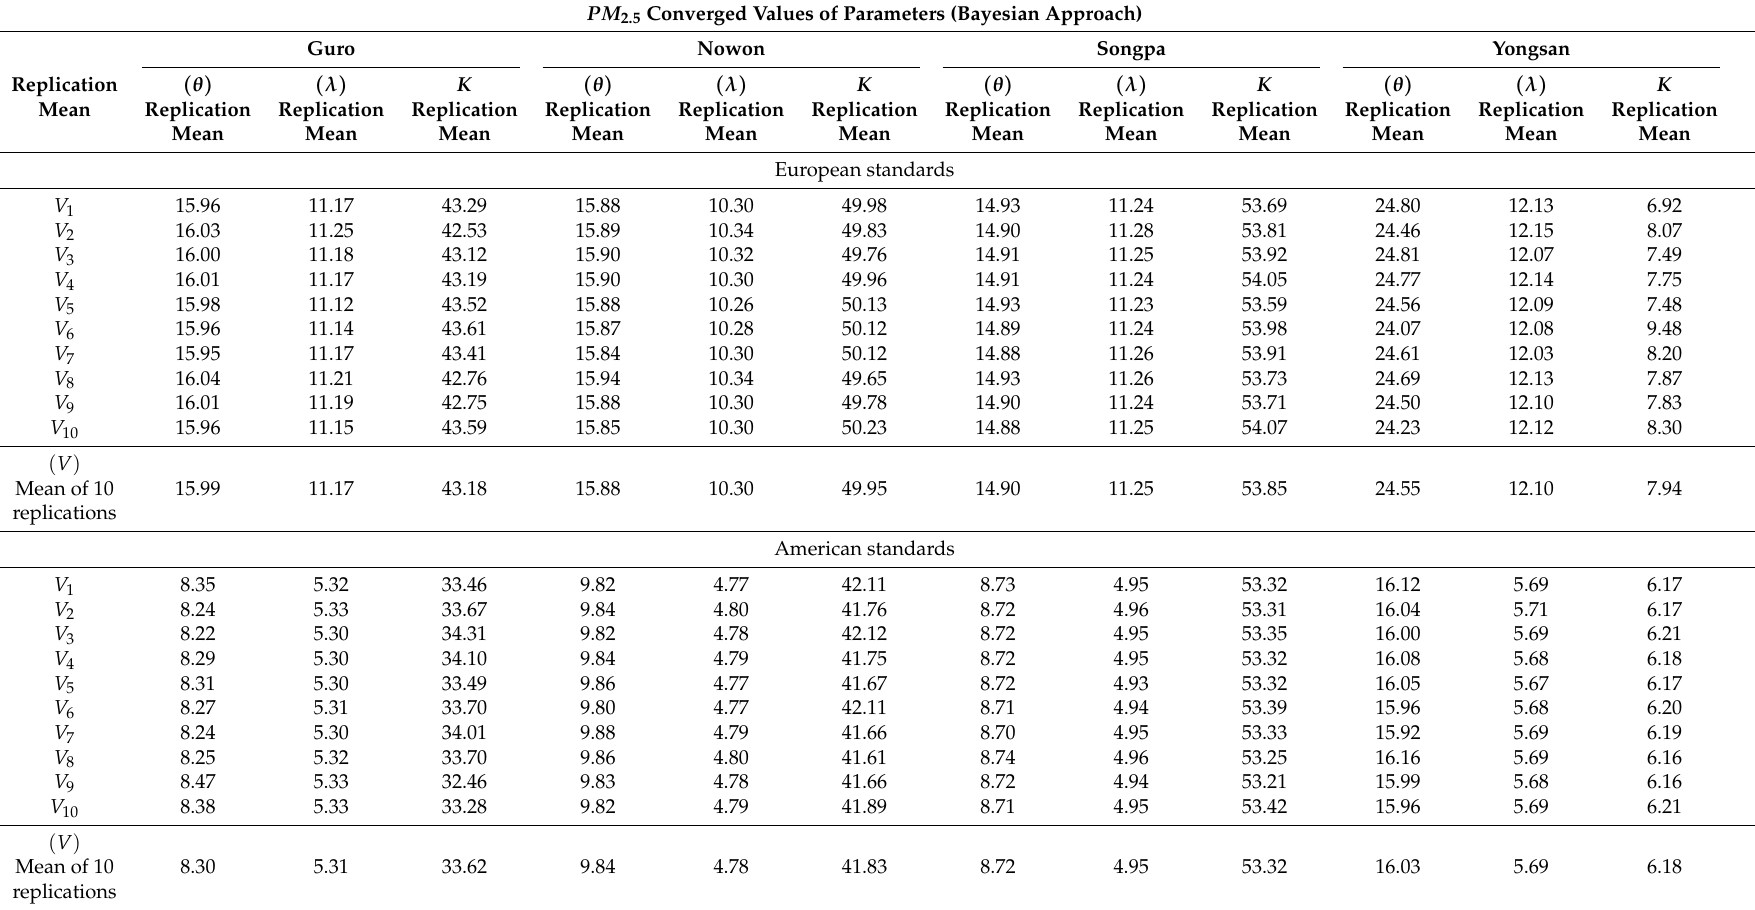
Table 9. PM 2.5 Converged values of parameters (Bayesian